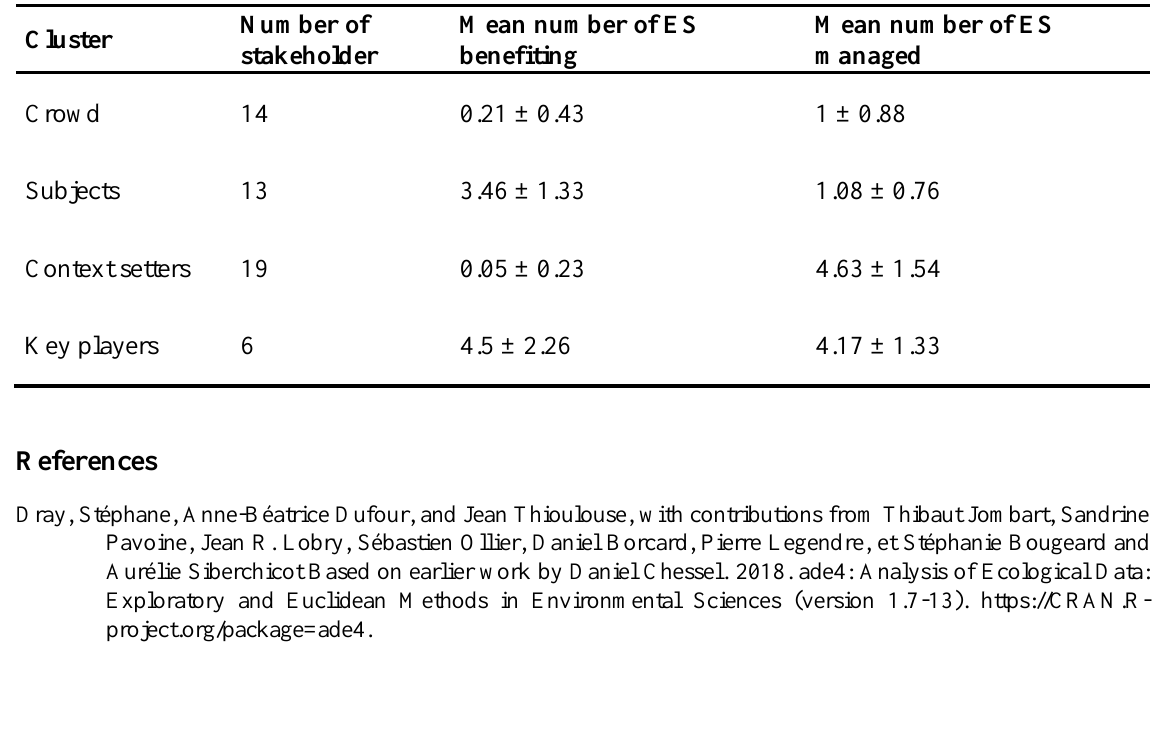
Table A6.1. Characteristics of the